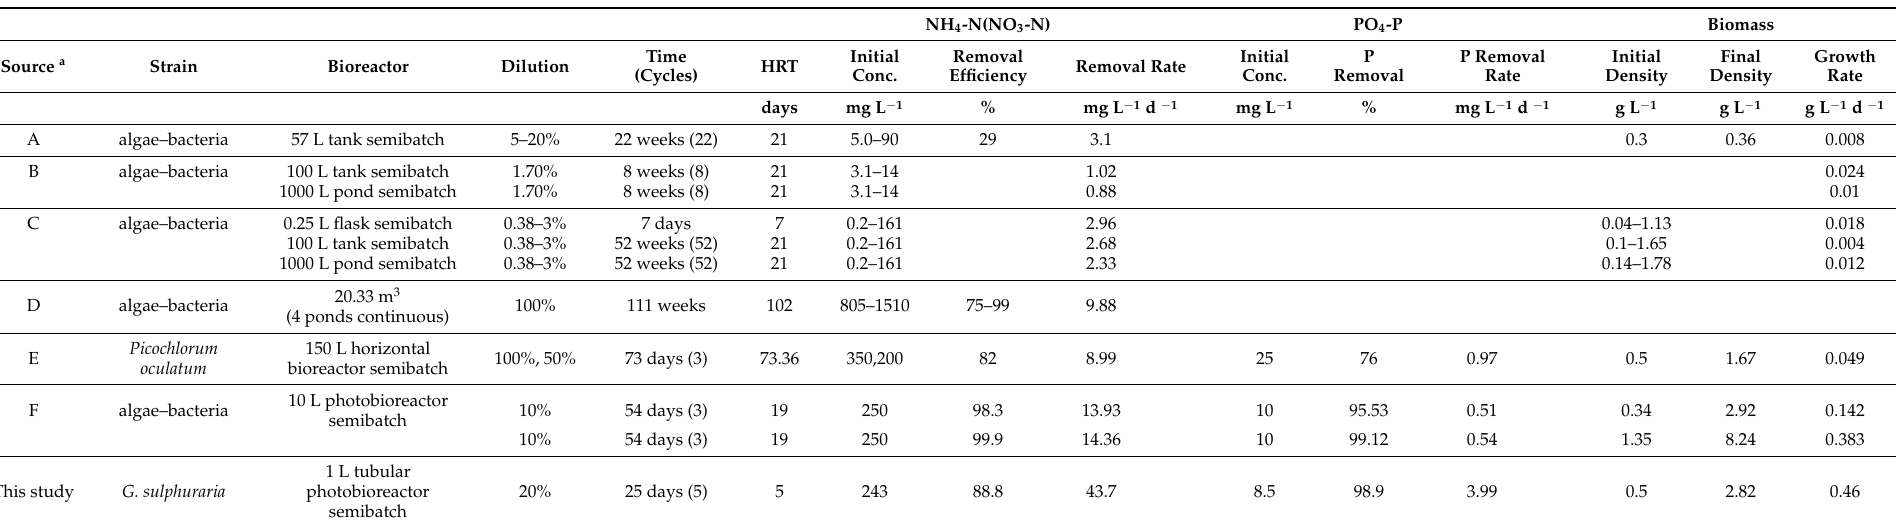
Table 5. Nutrient removal and biomass production from landfill leachate using long-term experiments: this study vs. literature